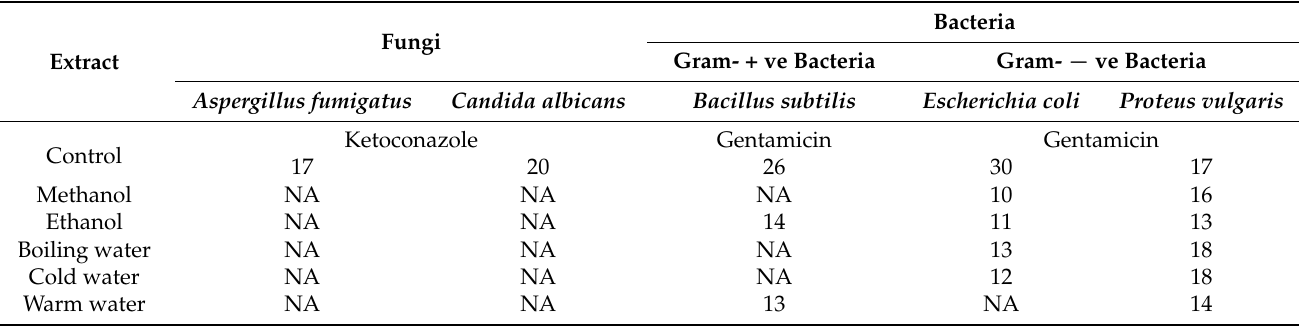
Table A2. Antimicrobial activity (mm) of the different extracts of Taif’s rose flowers on the pathogenic fungal and bacterial strains. NA: no activity.